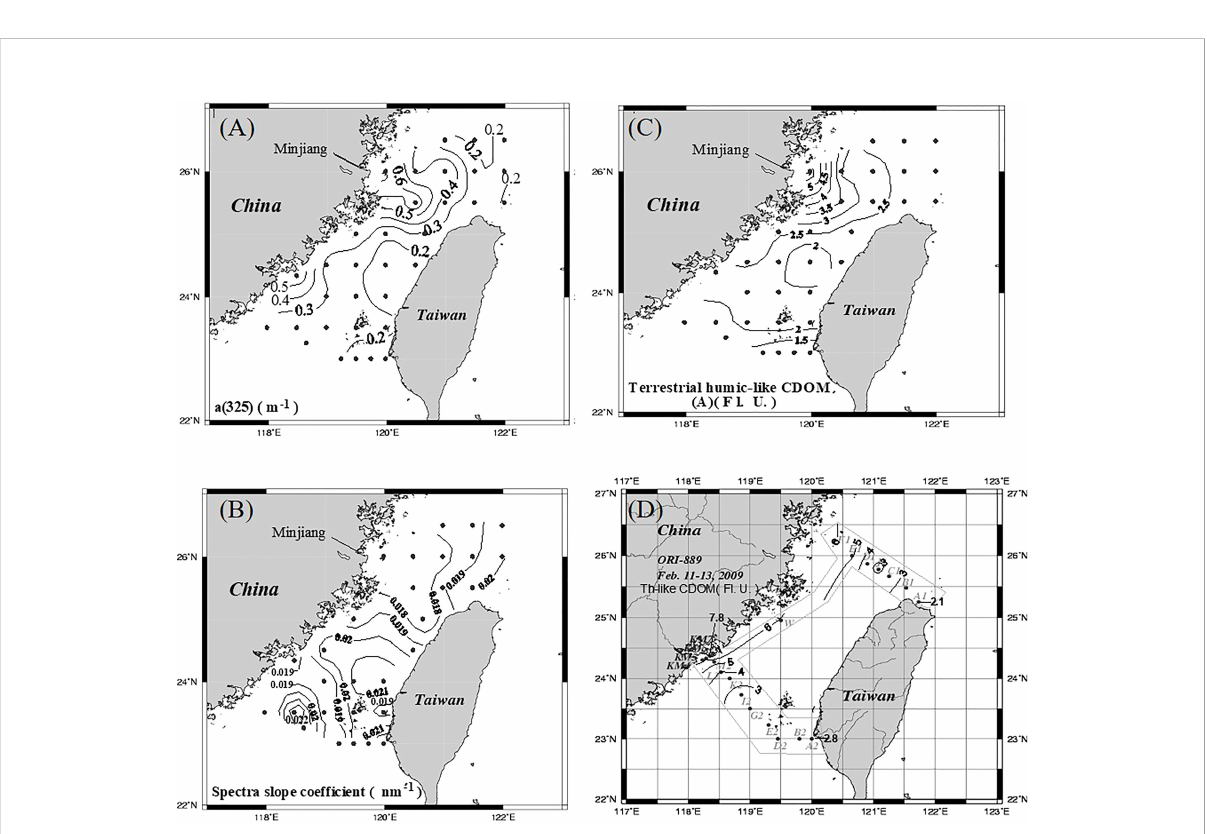
FIGURE 7 Spatial distributions of CDOM absorption coef fi cient values (A) , CDOM spectral slope coef fi cient values (B) , and terrestrial humic-like (Th-like) CDOM concentrations (C) in TS surface waters in early summer (CR 1353), and spatial distribution of Th-like CDOM concentrations in TS surface waters (D) in winter (CR 889).